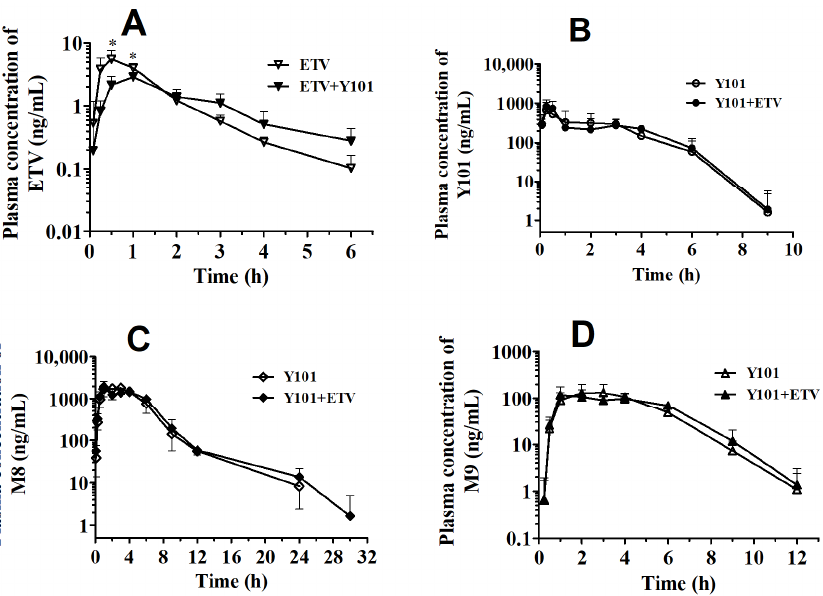
Figure 3. Mean plasma concentration–time curves of ETV ( A ), Y101 ( B ), M8 ( C ) and M9 ( D ) after intravenous administration of Y101 (25 mg/kg) and Y101 + ETV (0.06 mg/kg). Data are expressed as mean ± SD (* p < 0.05 vs. Y101 group; n = 4).